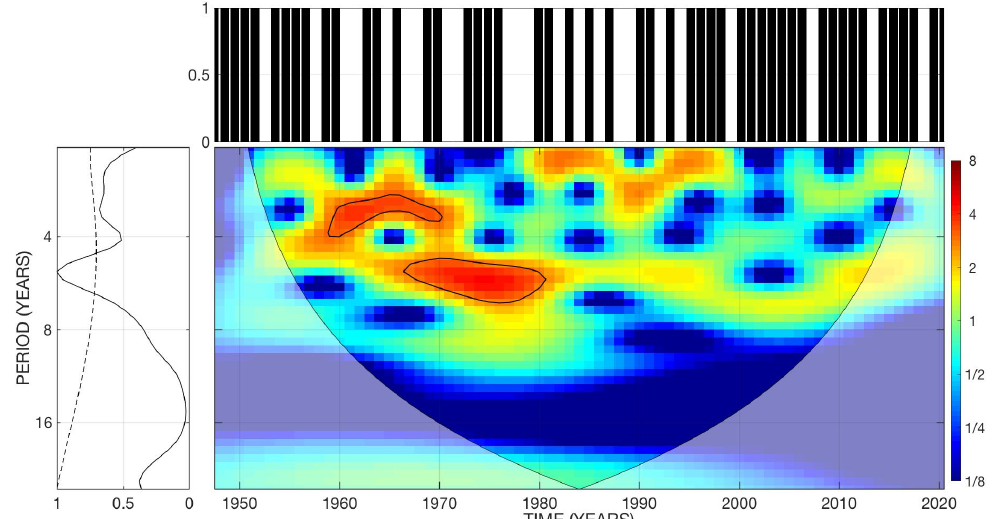
Figure 5. Time-frequency wavelet results of category 3 Atlantic hurricanes between 1950 and 2021. The digital time series for category 3 Atlantic hurricanes is shown in the upper panel. The global wavelet spectrum is shown in the left panel. The central panel shows the calculated wavelet Power Spectral Density (PSD) in normalized units adopting the red-green-blue color scales. The Cone Of Influence (COI, “U”-shaped curve with shaded outer zones) shows the possible edge effects in the PSD. The time-frequency regions with wavelet spectral power detection above 95% confidence level are marked with thin black